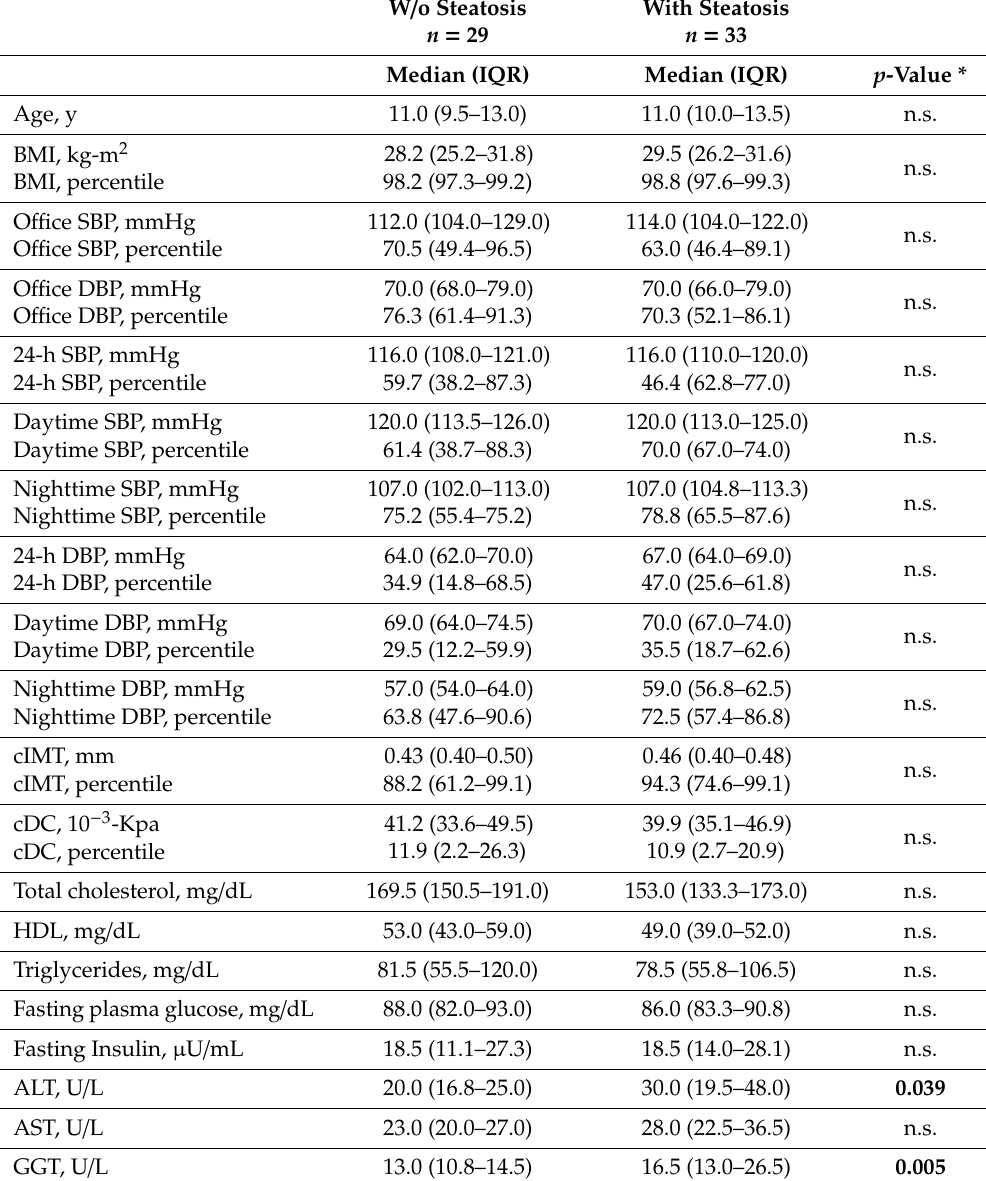
Table A1. General characteristics of children and adolescents with and without liver